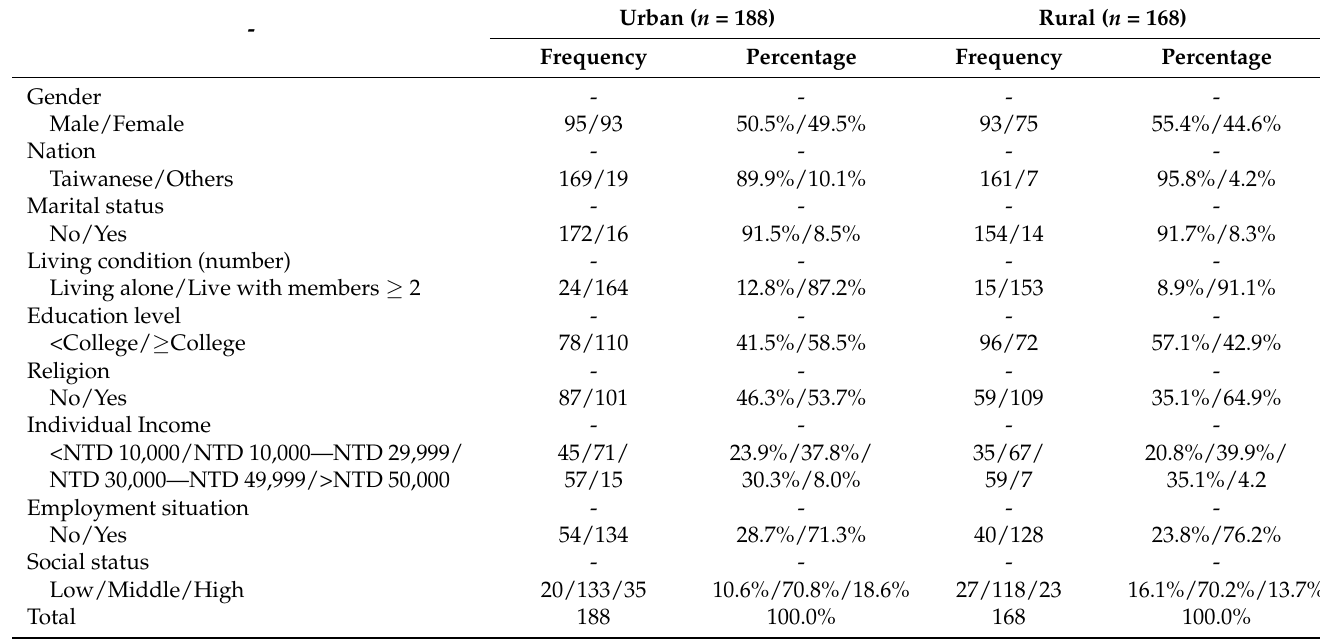
Table 1. Sociodemographic analysis ( n =